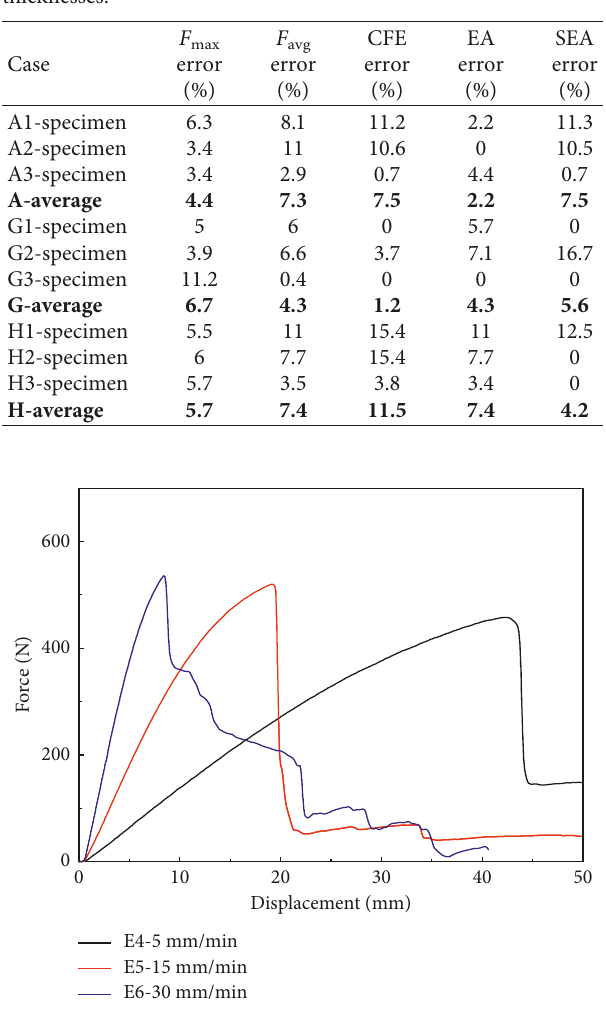
Figure 12: Comparison of different stacking sequence for speci- mens: CFE.